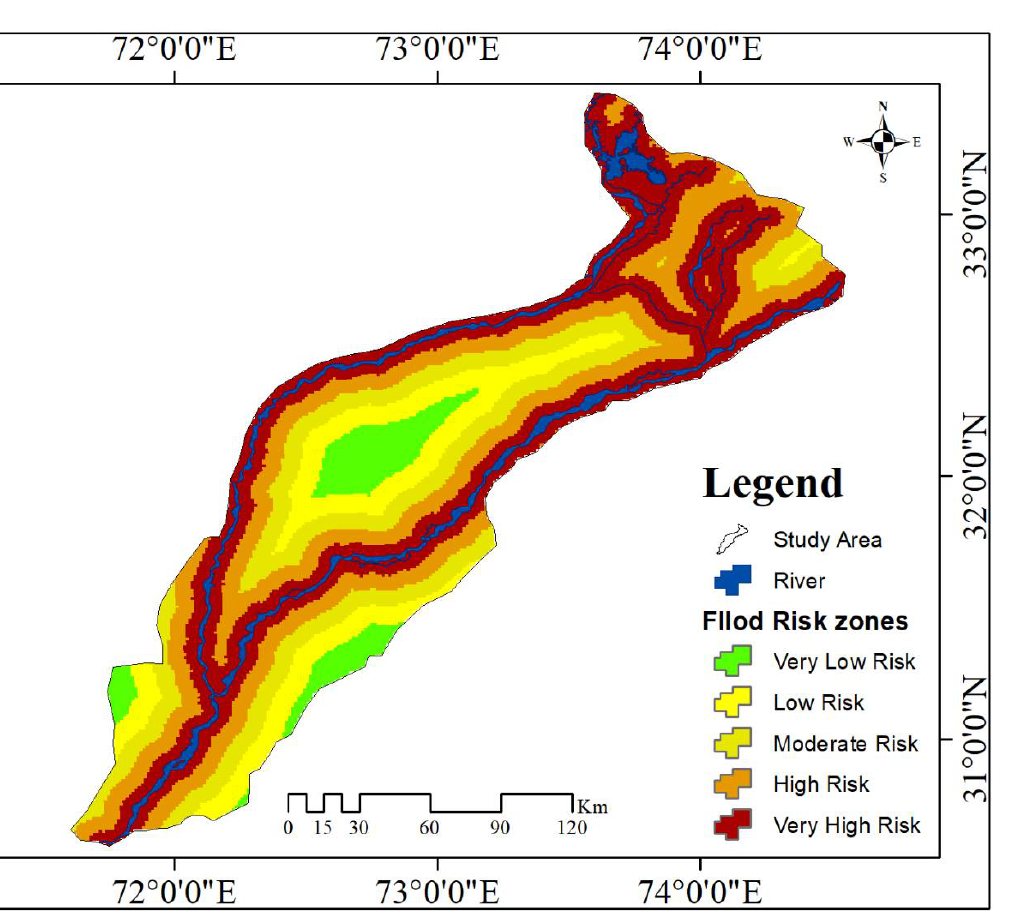
Figure 6. Flood risk zones map of the study area using the AHP and FR models .